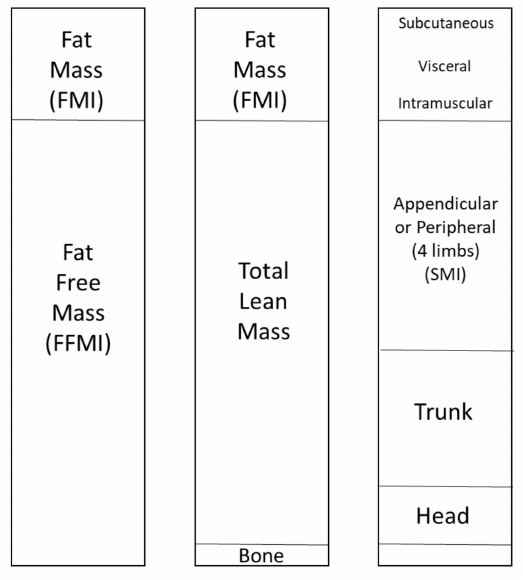
Figure 1. DXA compartment view of body